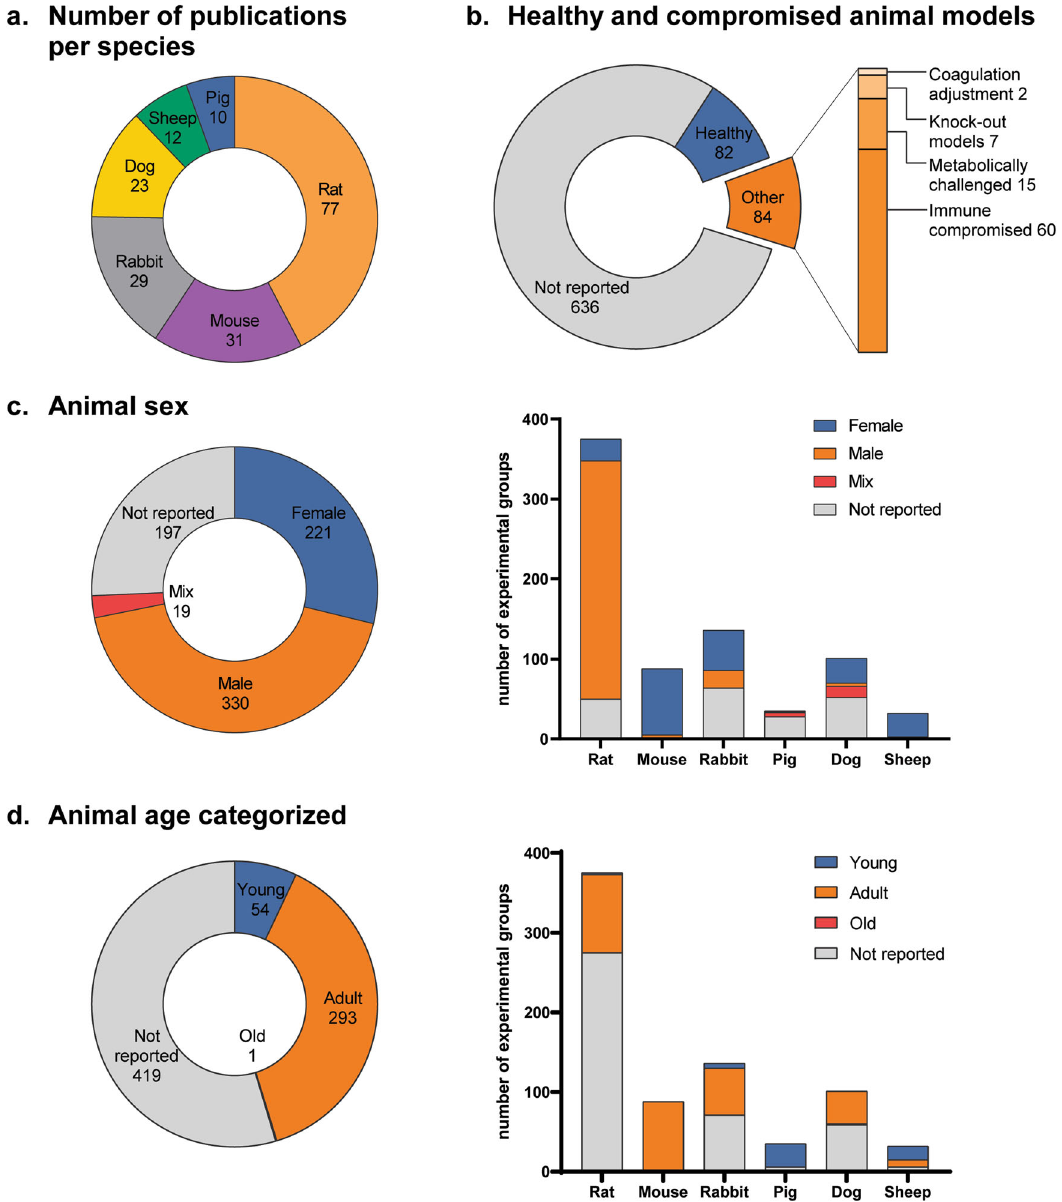
Fig. 3 Mapping of study characteristics included in the systematic review. a Number of publications per species of all included studies. b Number of subgroups reporting health status of animals all included studies. Compromised animal models include; coagulation adjustments (e.g., platelet inhibitor treatment), Knock out (KO) models (e.g., Myeloid speci fi c PDGF KO, CCR2 KO), metabolically challenged models (e.g., Diabetic animals), and immune compromised animals (e.g., SCID/beige, athymic). c Reported animal sex, and d animal age of all experimental groups and categorized per animal species according to cut-off values described in Table